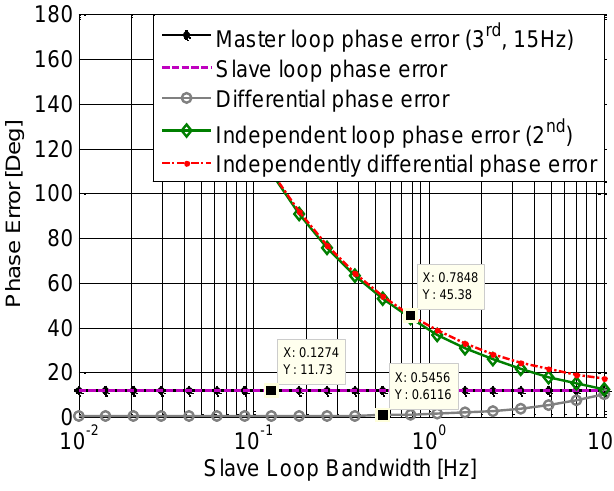
Figure 10. Phase jitter induced by oscillator